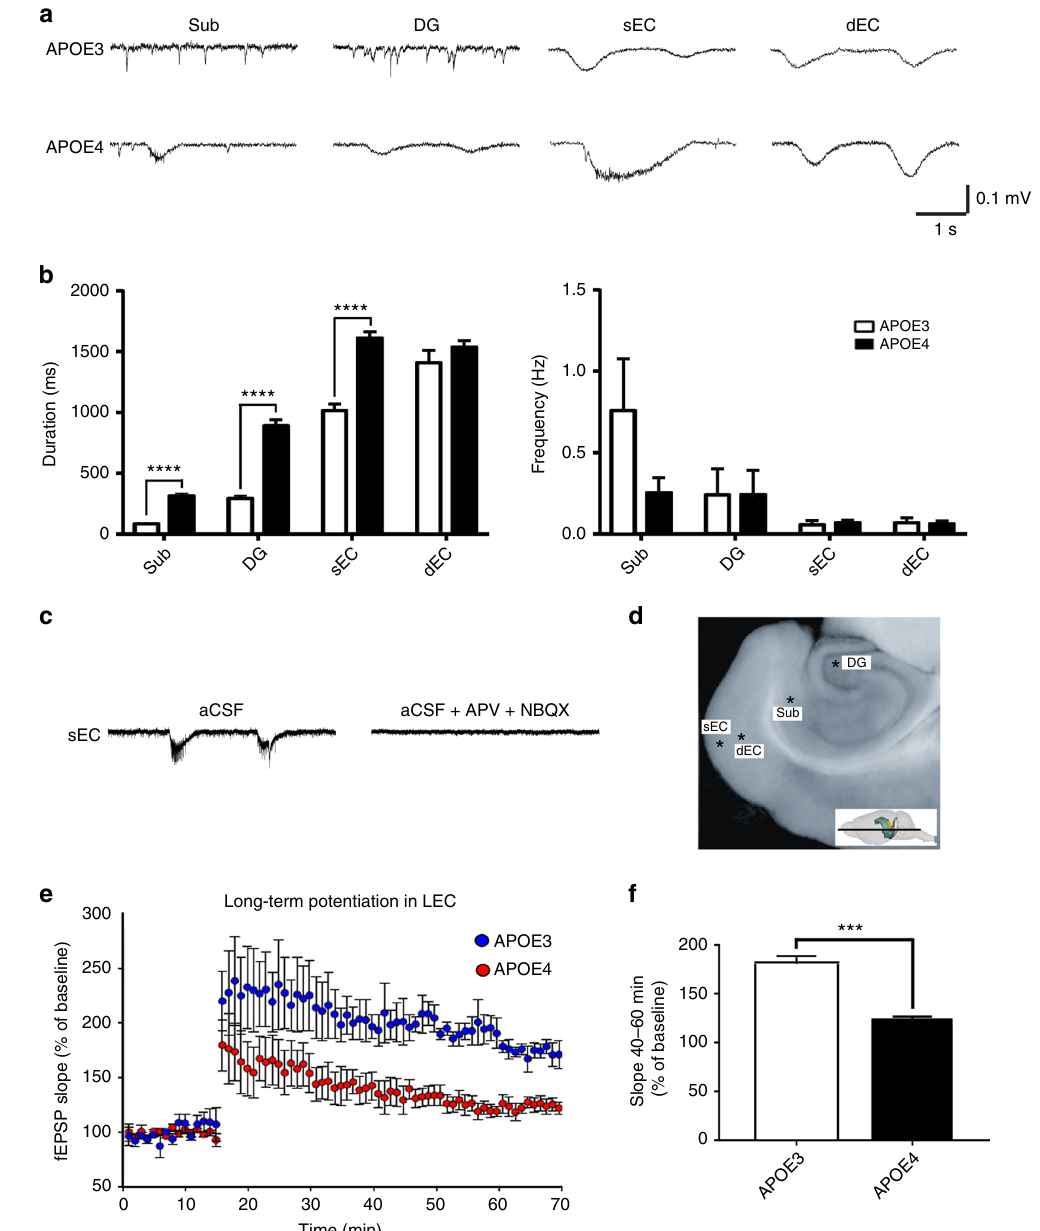
Fig. 4 APOE4 is associated with abnormal excitability and synaptic plasticity in the hippocampal formation. In vitro electrophysiology was performed on horizontal hippocampal brain slices from aged APOE mice (mean age = 20 months; 5 APOE3 and 4 APOE4 males). a Representative traces of spontaneous extracellular fi eld potentials (sEFPs) recorded in the subiculum (Sub), the dentate gyrus (DG), super fi cial layers (II/III) of the EC (sEC), and deep layers (V/VI) of the EC (dEC) in APOE3 and APOE4 mice. b Event durations and frequencies comparing APOE3 and APOE4 mice in the different regions recorded (mean values and SEM). Event durations in the Sub, DG, and sEC were found to be increased in aged APOE4 mice (Mann – Whitney; p < 0.001). c Representative sEFPs in APOE4 sEC before and after bath application (25 min) of AP-V (30 μ M) and NBQX (10 μ M). d A representative horizontal hippocampal brain slice used in this study, with asterisks denoting the location where each electrode was placed and the insert depicting the location of the horizontal slice in the mouse brain. e Cortico-cortical LTP in super fi cial EC induced by high-frequency stimulation (HFS, 3 trains of 100 pulses at 100 Hz, 10 s interval). Stimulation electrode was placed in lateral EC layer II, and the recording electrode was placed in lateral EC layers III/II. Stimulus intensity was selected to be 50 – 60% of the maximum amplitude of the fEPSP observed in the input – output curve, and a baseline for 15 mins was obtained before HFS. The slope of the initial component of the fEPSP (10 – 90%) was normalized to baseline and compared between APOE3 and APOE4 mice (repeated measures ANOVA; F (1,6) = 15.001, p = 0.008). f Mean value of potentiation between 40 and 60 min after LTP induction, comparing APOE3 and APOE4 ( t (6) = 3.878, p = 0.008). (** p <